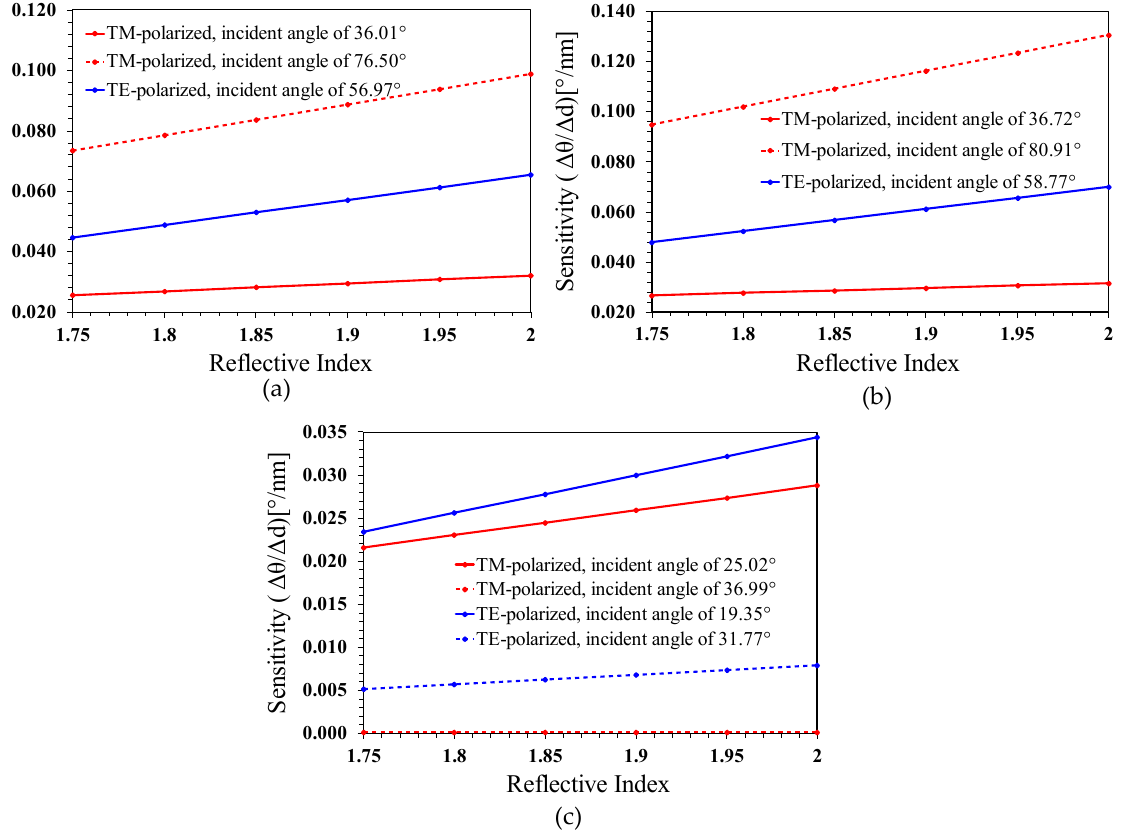
Figure 9. Sensitivity curves as a function of the RI of DLC films for the optimized CPWR sensors: ( a ) sapphire prism/TiN/AlN/air, ( b ) magnesium oxide prism/TiN/AlN/air, and ( c ) silicon prism/TiN/AlN/air.